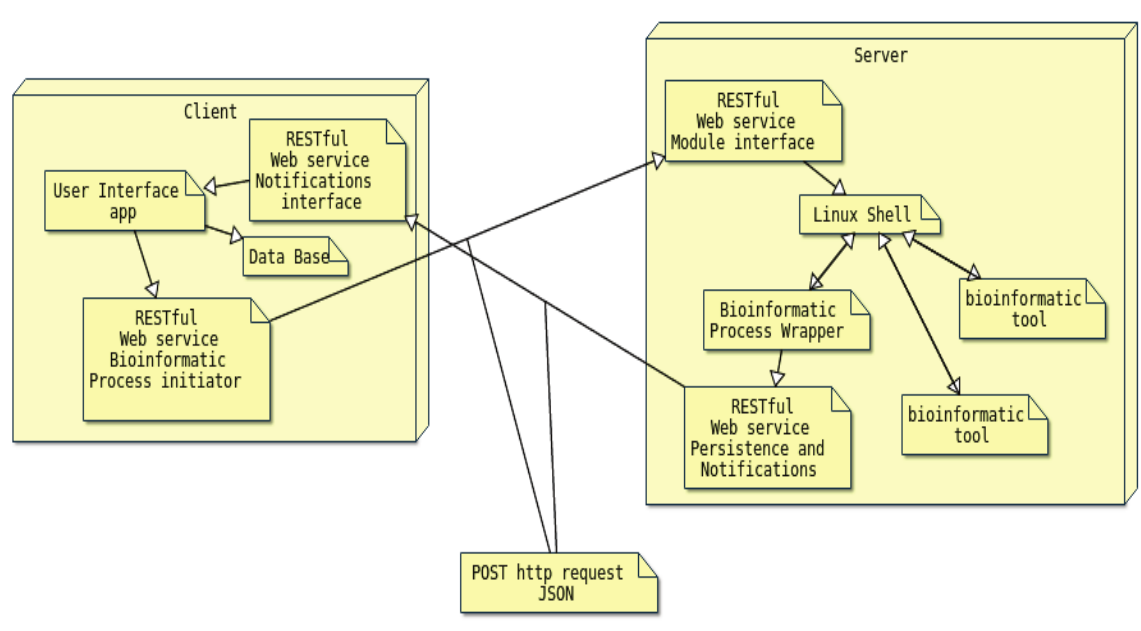
Figure 9: Deployment diagram of bioinformatics platform, where the JSON data format is the way the user interface and processing modules